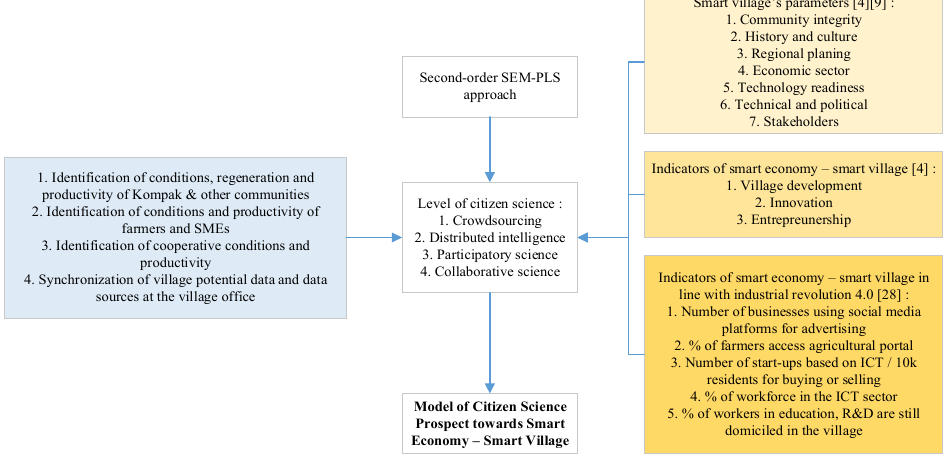
Fig. 1. The theoretical framework of the citizen science model for a smart economy